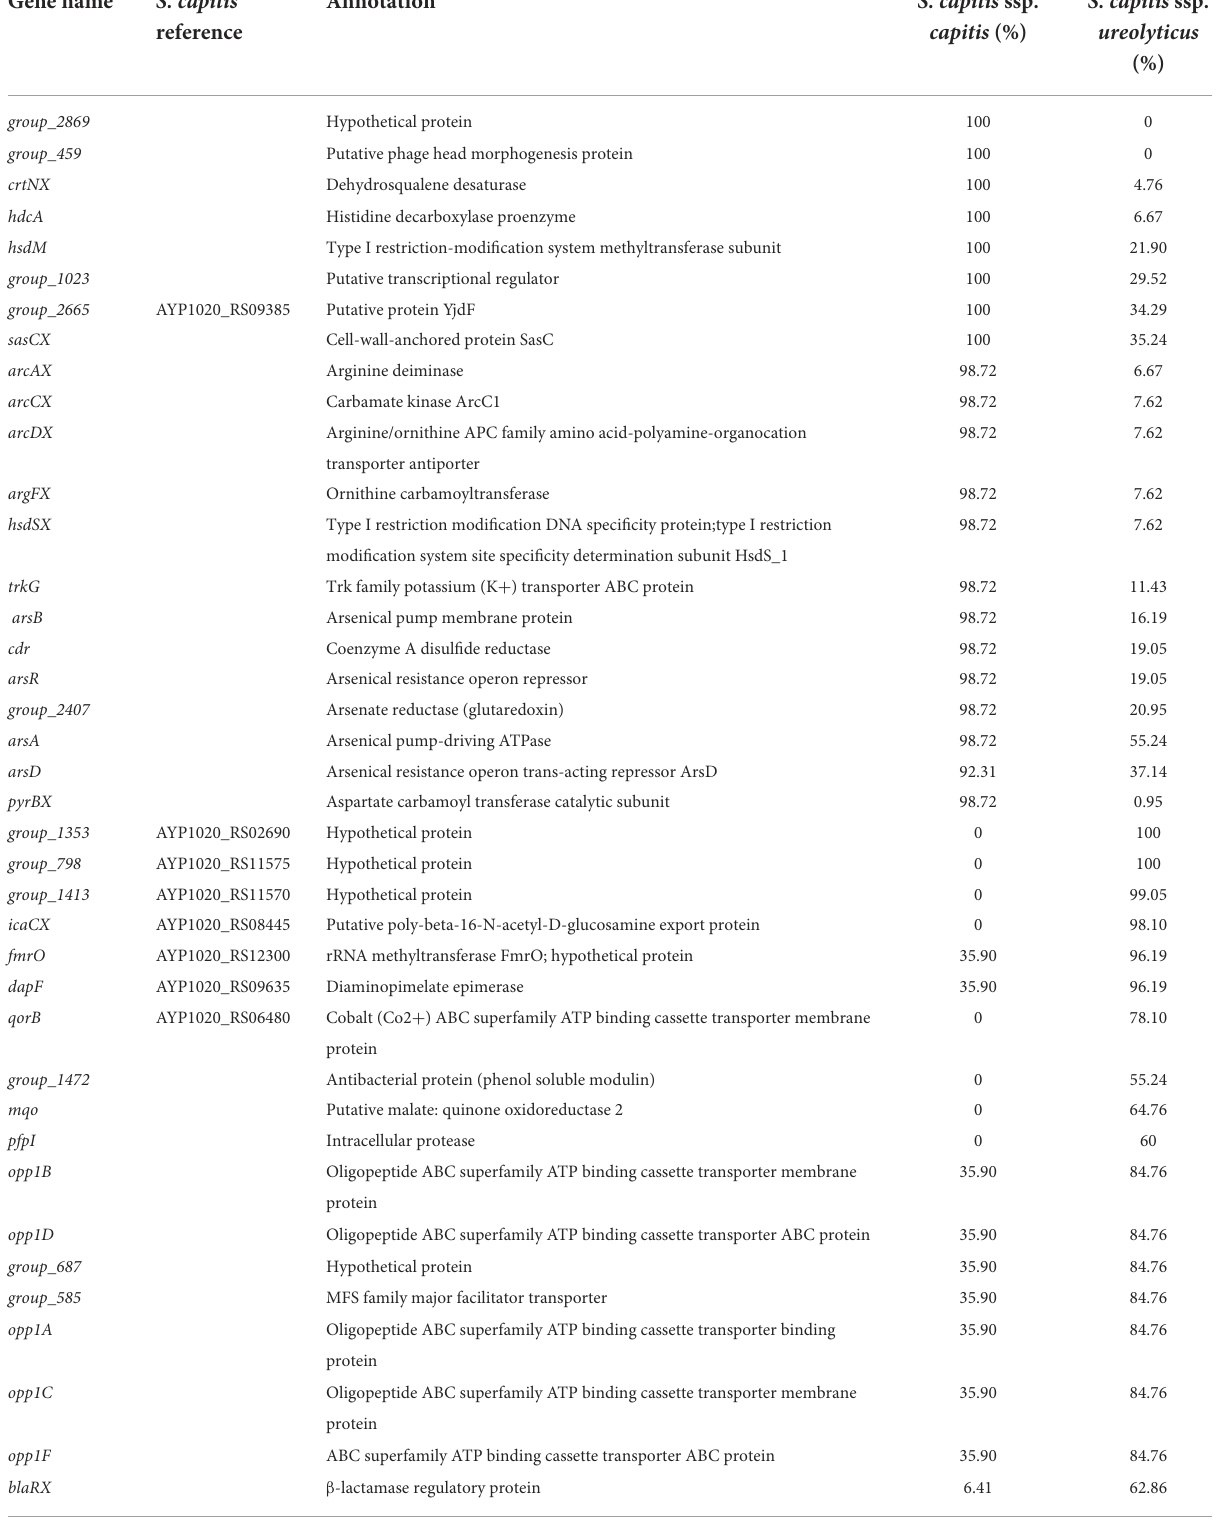
TABLE 2 Gene clusters found significantly enriched in either S. capitis ssp. capitis or ssp. ureolyticus ( p <